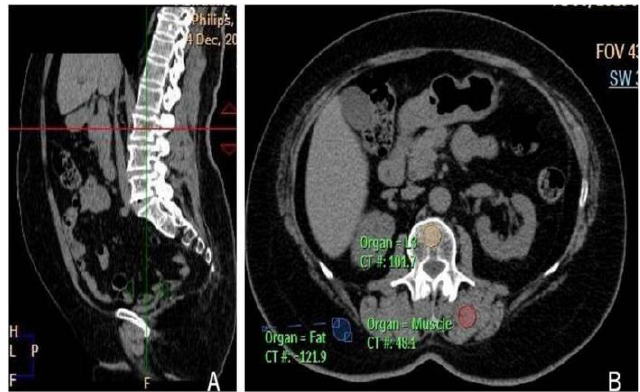
Figure 1 : Computed tomography (A) sagittal section showing how to choose the vertebra required for Bone Mineral Density measurement, (B) cross-section showing the areas required for cancellous bone, muscles, and